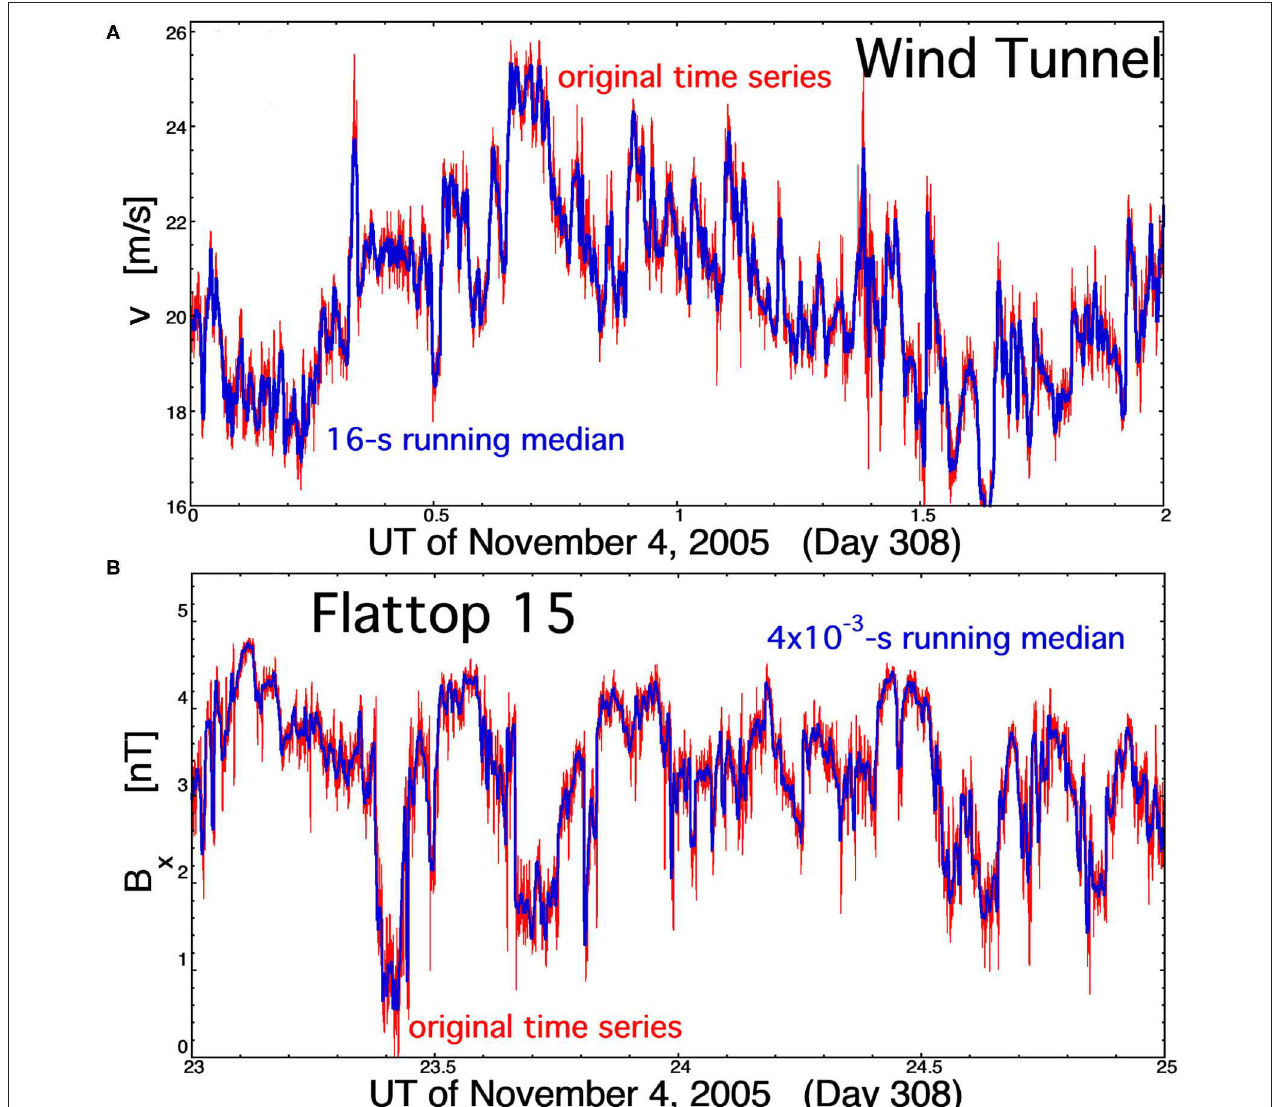
FIGURE 10 | Running medians (blue curves) are compared with the measurement time series (red curves) for (A) the streamwise velocity v in the wind tunnel Navier–Stokes turbulence and (B) the radial component of the magnetic field B x for the Alfvénic solar wind fluctuations of Flattop 15. The running medians are over timescales that are about five times longer than the period corresponding to the high-frequency breakpoints of the power spectral